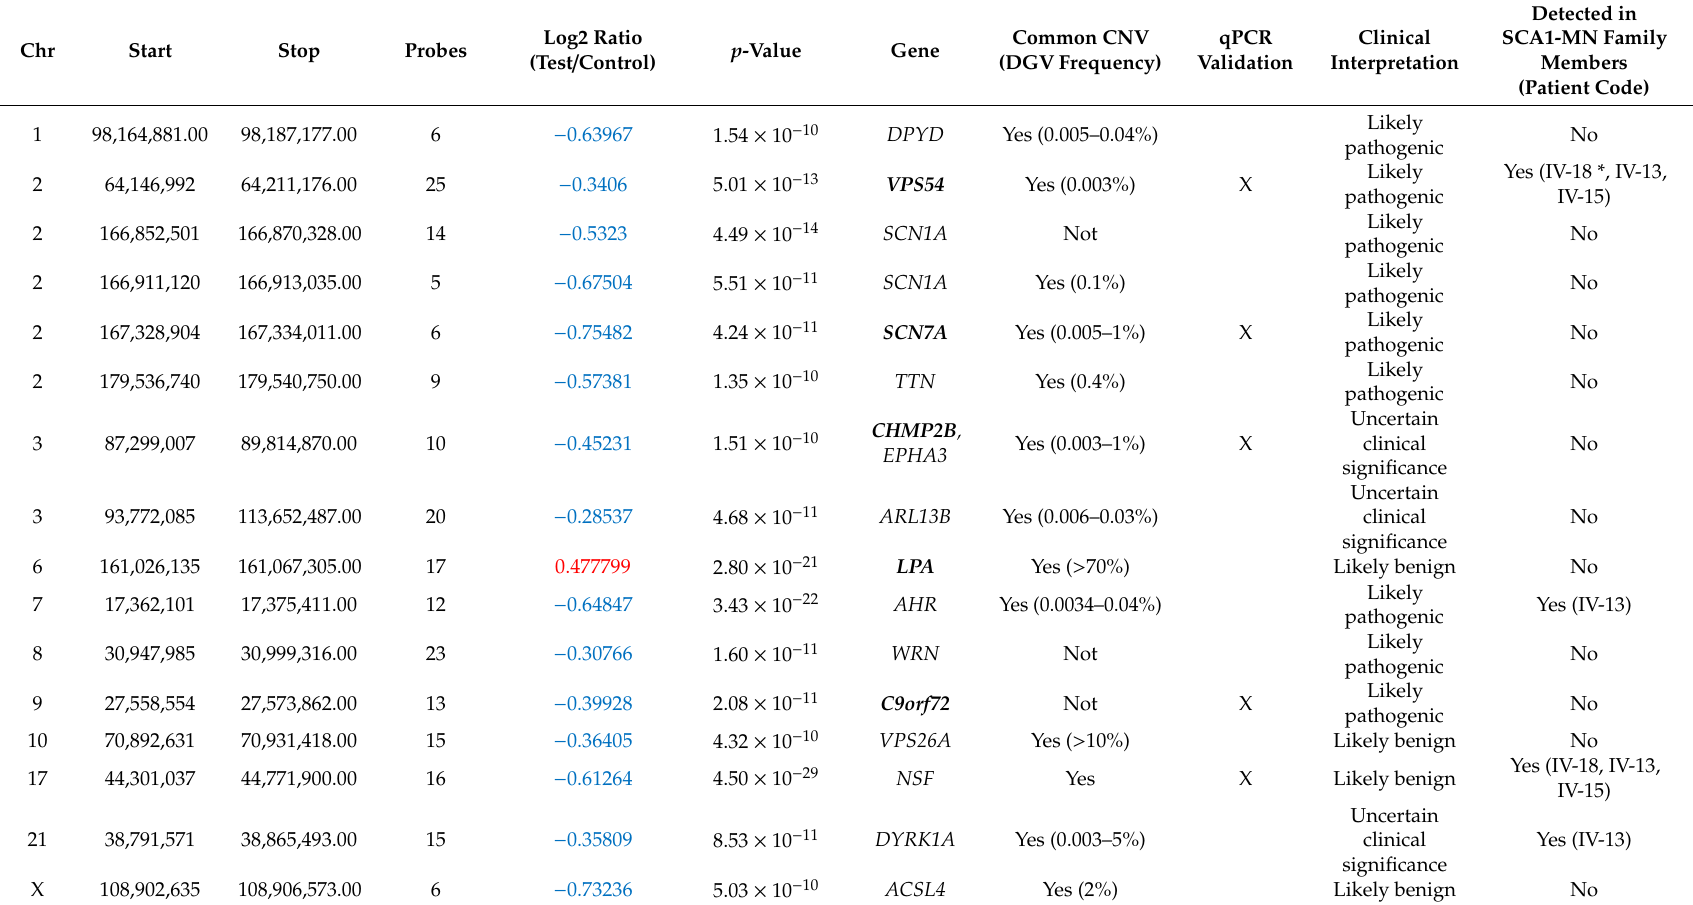
Table 2. Copy number variations (CNVs) identified in the ALS proband by NeuroArray